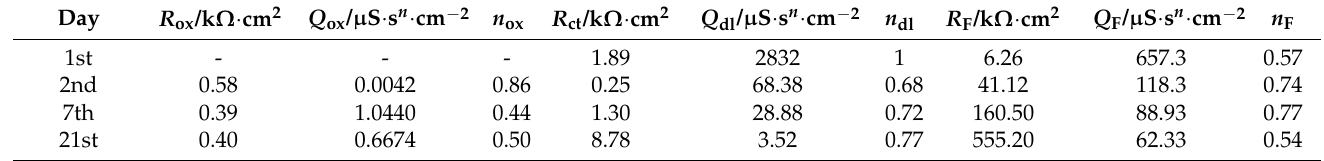
Table 8. EIS data for CuSn6 for continuous immersion in simulated urban rain at pH